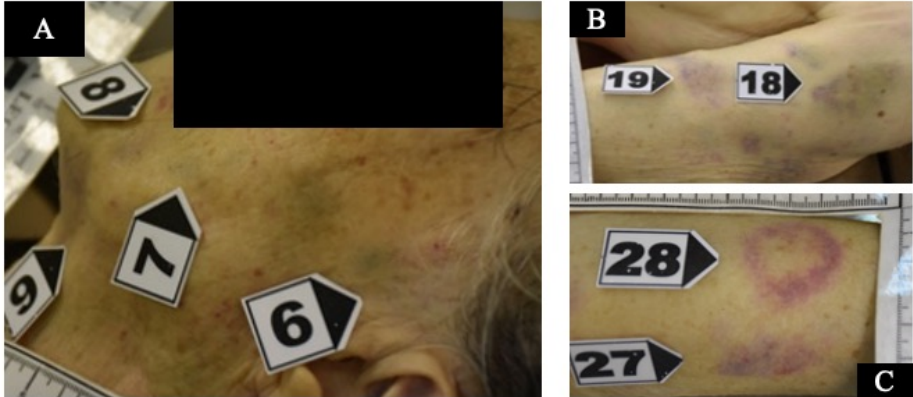
Figure 2. ( A ) bruises on the left side of the face; ( B ) bruises on the upper left arm; ( C ) bruises on the upper right arm.